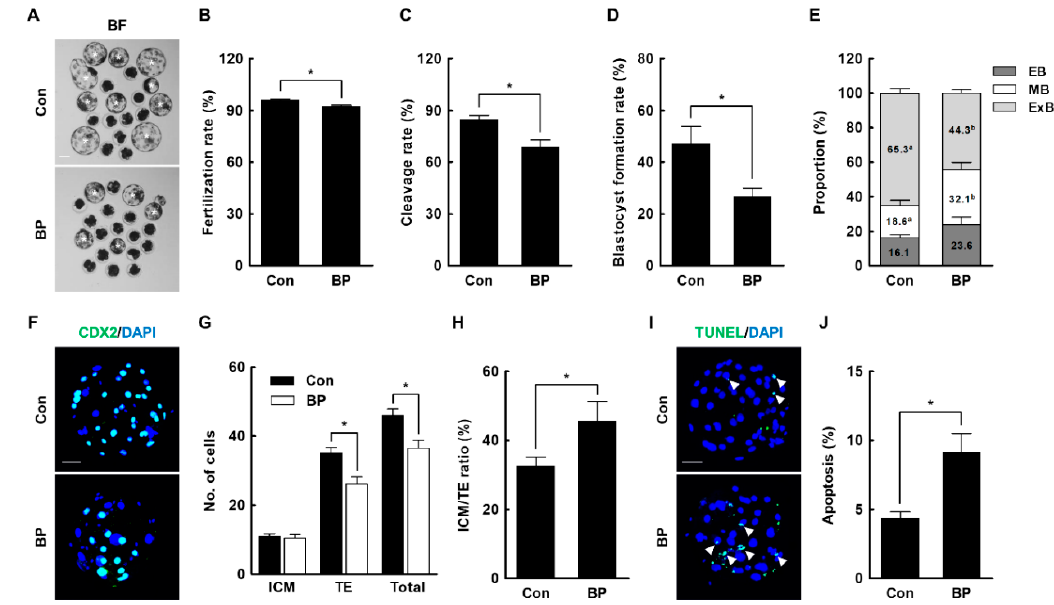
Figure 2. E ff ects of butylparaben (BP) exposure during in vitro maturation (IVM) on embryonic development after in vitro fertilization (IVF). ( A ) Representative photographs of blastocysts developed from control and BP-treated oocytes after IVF. Bar = 100 µ M. ( B ) Fertilization rates ( C ), cleavage rates, and ( D ) blastocyst formation rates of embryos from control and BP-treated oocytes after IVF (Con; n = 181, BP; n = 118). ( E ) Proportion of blastocyst stages of control and BP-treated oocytes after IVF (Con; n = 79, BP; n = 29). ( F ) Representative immunofluorescence photographs of CDX2 / DAPI using blastocysts developed in the BP-treated and control groups. Merged images (light green) between DAPI (blue) and CDX2 (green) signals are shown. Bar = 50 µ M. Quantification of ( G ) the inner cell mass (ICM), trophectoderm cells (TE), total cell numbers, and ( H ) ICM / TE ratios in the BP-treated and control groups (Con; n = 20, BP; n = 20). ( I ) Representative immunofluorescence photographs of terminal deoxynucleotidyl transferase-mediated dUTP-digoxygenin nick end-labeling (TUNEL) assay using blastocysts developed in the BP-treated and control groups. Merged images (light green) between DAPI (blue) and TUNEL (green, white arrow) signals are shown. Bar = 50 µ M. ( J ) Quantification of proportion of apoptotic cells in the BP-treated and control groups (Con; n = 21, BP; n = 21). The data are from three independent experiments and the values represent the mean ± SEM. * p < 0.05. Values with di ff erent superscript letters (a and b) di ff er significantly ( p < 0.05). EB, early blastocyst; MB, middle blastocyst; ExB, expanded blastocyst.